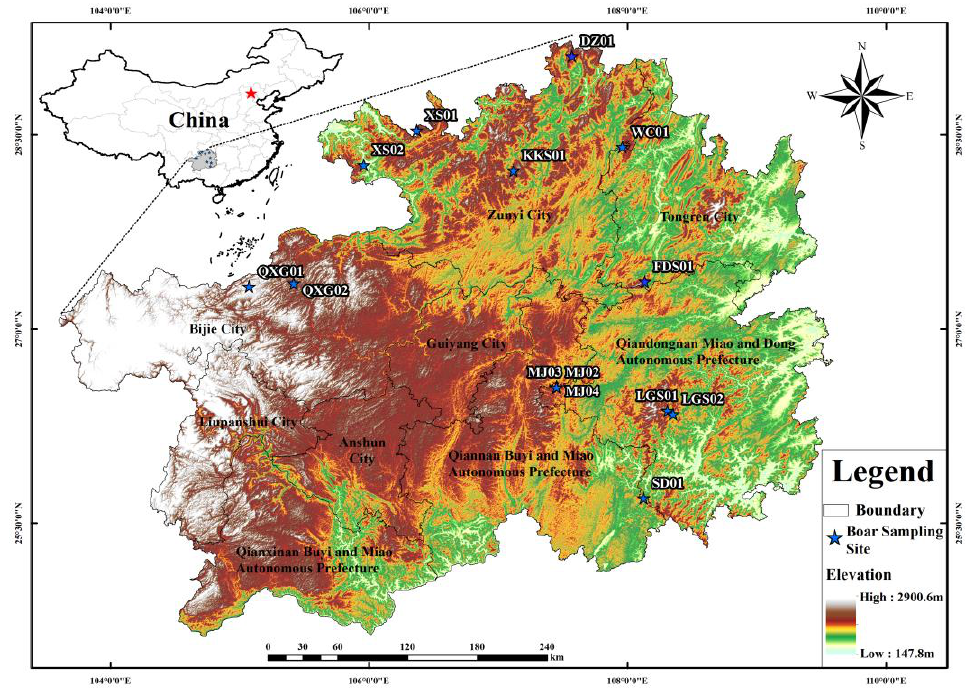
Figure 1. Sampling sites of 14 healthy wild boars.